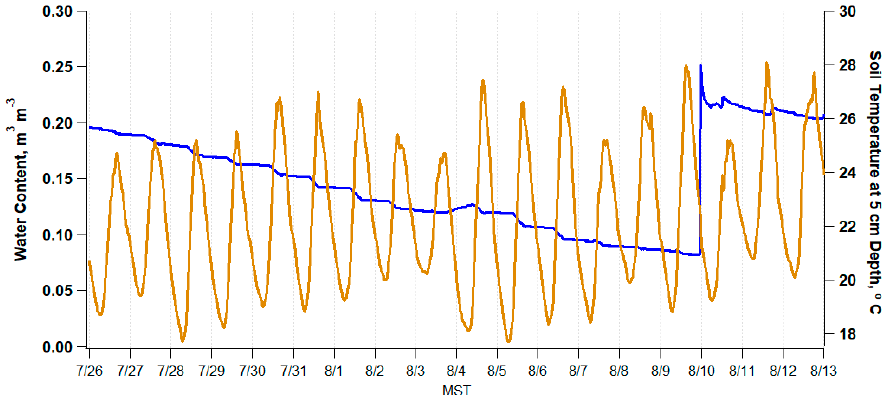
Figure 4. Soil temperature and water content in the top 5 cm of the soil from 26 July to 13 August 2015.